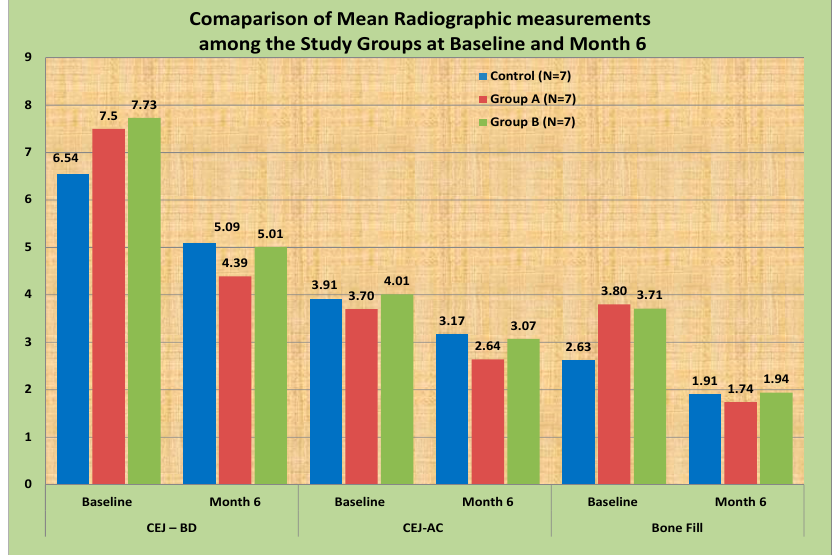
Figure 3. Comparison of Mean Radiographic measurements among the study groups at baseline and 6 months.